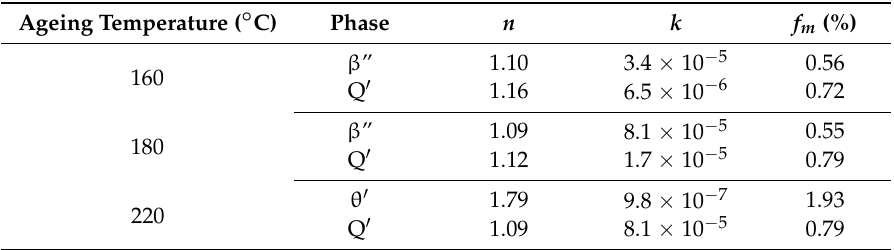
Table 3. Values of n , k and f m used to calculate the volume fraction of the precipitates by means of Equation (2). Ageing Temperature ( ◦ C) Phase